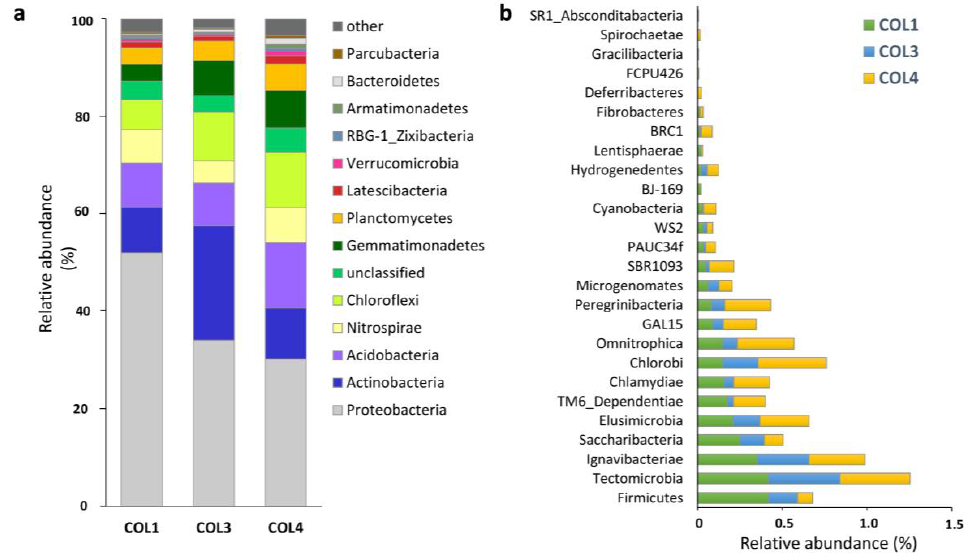
Figure 2. Taxonomic profiles of the moonmilk-associated microbiome at the phylum level across the three moonmilk sampling points (COL1, COL3, COL4). The main phyla of the microbiome are presented on the left ( a ), while the pattern of low-abundance taxa, named as ‘other’ (with a relative abundance of <1%) is displayed on the right ( b ).